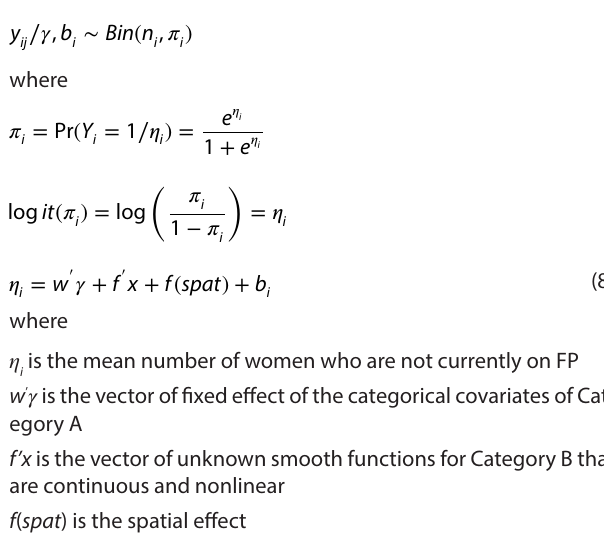
Table 2: Summary of diagnostic accuracy of the four models